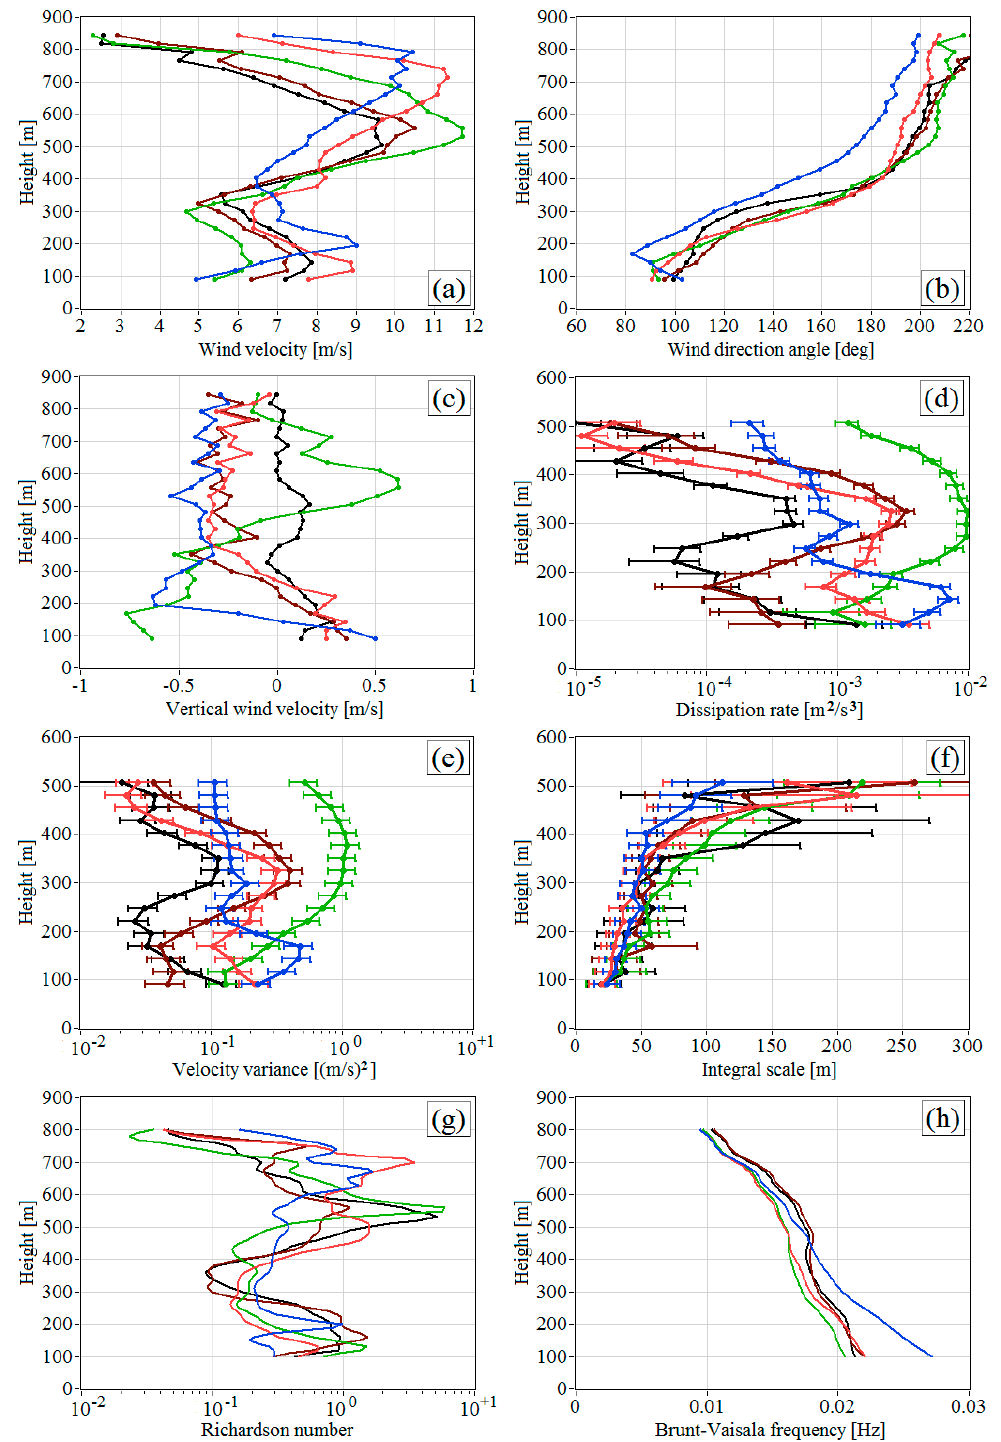
Figure 12. Vertical profiles of wind velocity ( a ), wind direction angle ( b ), vertical component of the wind vector ( c ), turbulent energy dissipation rate ( d ), variance of the radial velocity ( e ), integral scale of turbulence ( f ), Richardson number ( g ), and Brunt–Väisälä frequency ( h ) at 01:00 (blue curves), 02:00 (red curves), 03:00 (green curves), 04:00 (brown curves), and 05:00 LT (black curves). The data for ( a – g ) are taken from Figure 10.